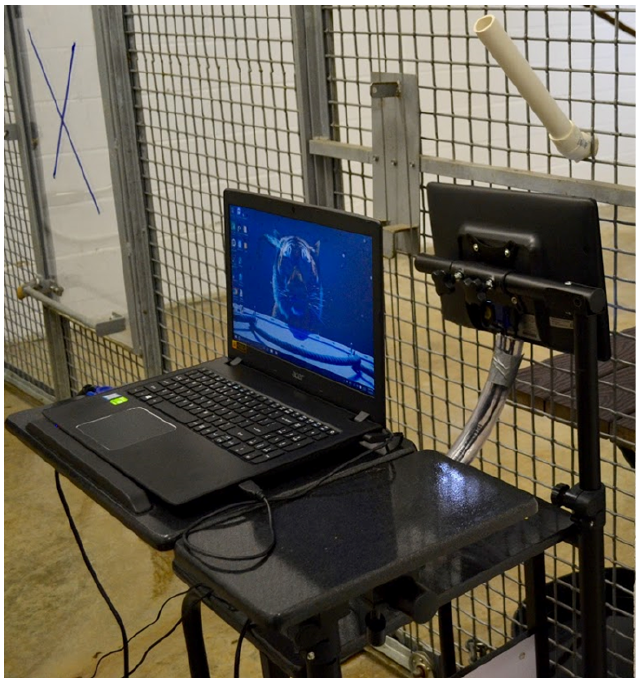
Portable Operant Discrimination Training/Testing